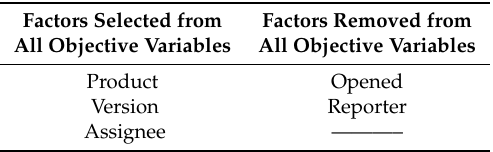
Table 5. The selection results of explanatory